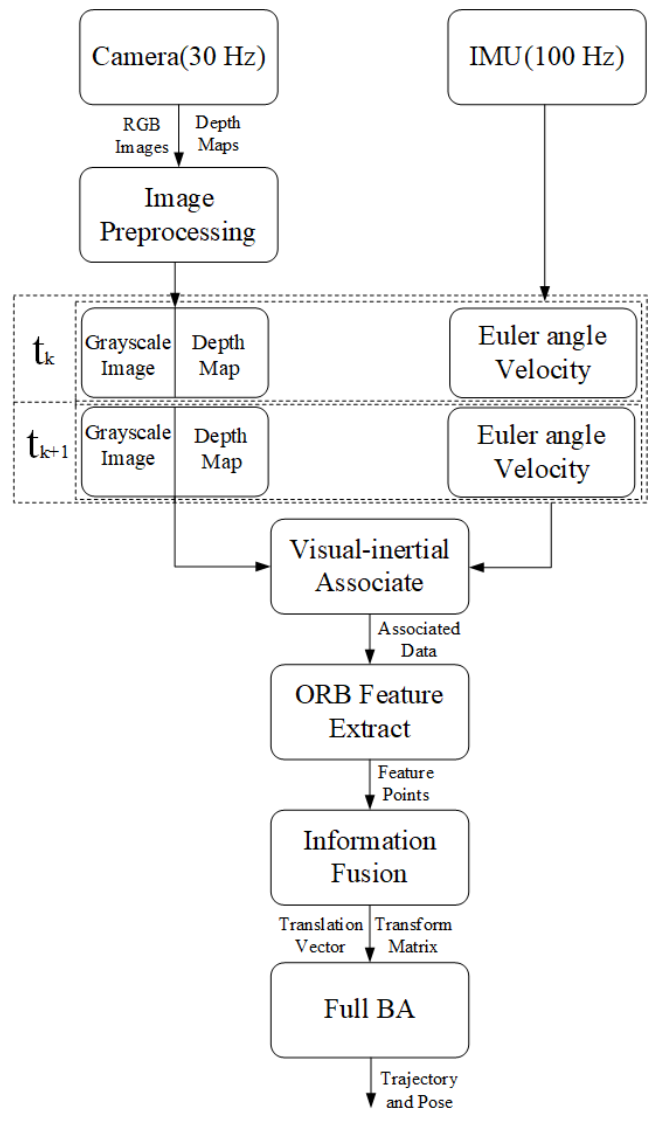
Figure 4. Architecture of the algorithm.